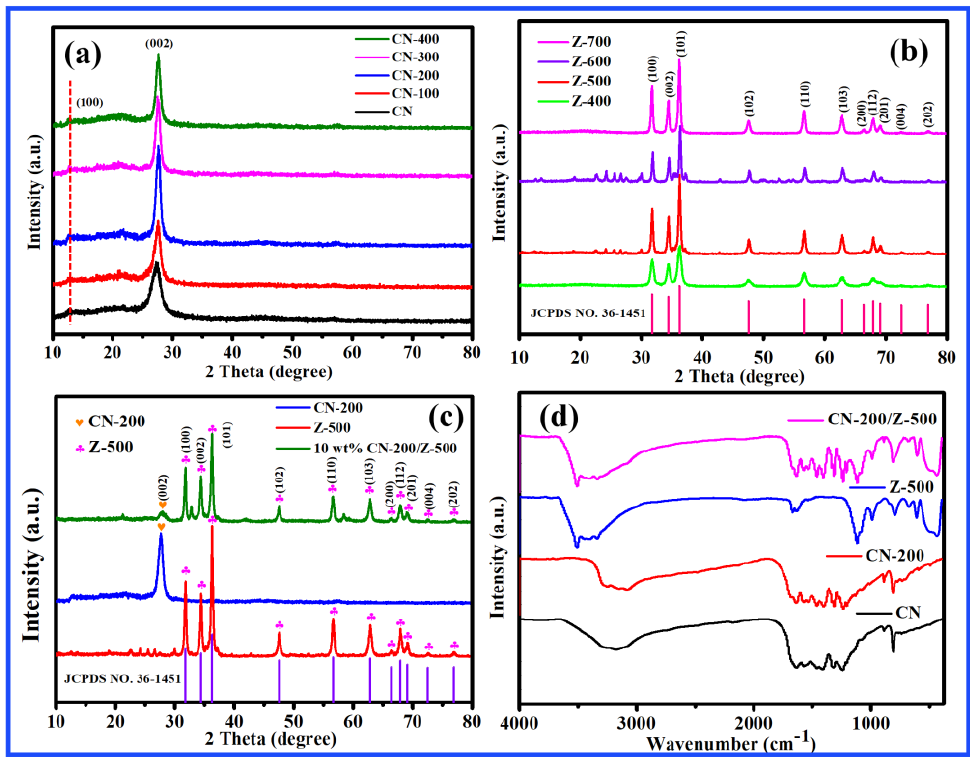
Figure 1. ( a ) XRD patterns of CN prepared under different absorbed radiation doses; ( b ) XRD patterns of ZnO prepared at different calcination temperatures; ( c ) XRD patterns of CN-200, Z-500, and 10 wt.% CN-200/Z-500; ( d ) infrared characterization of CN, CN-200, Z-500, and 10 wt.% CN-200/Z-500.